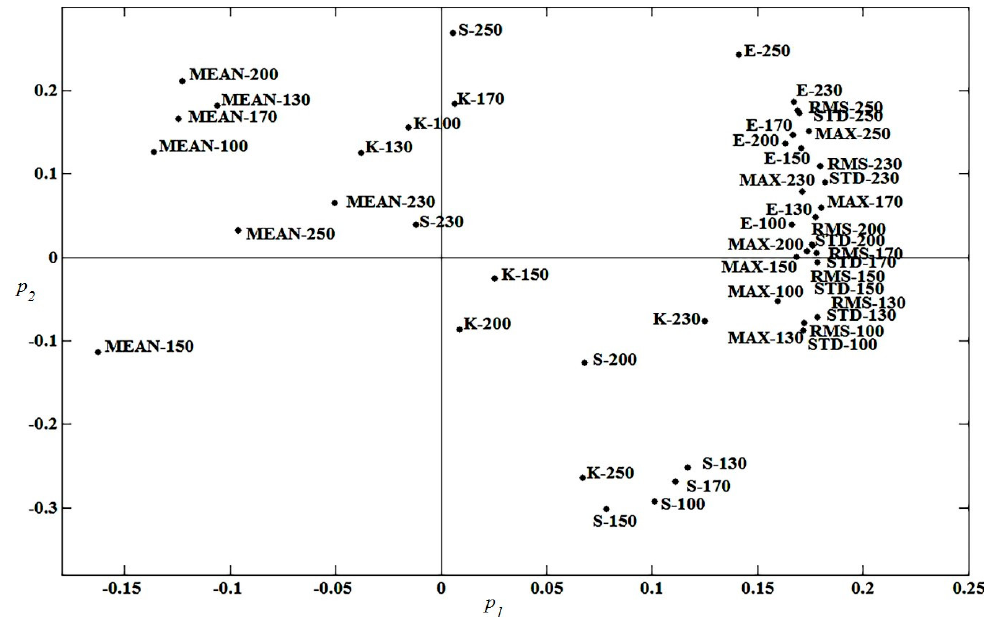
Figure 9. The p 1 – p 2 loading plot of the PCA model built on AU signal attenuation features. MAX: maximum, STD: standard deviation, E: energy, RMS: root mean square, S: skewness, K: kurtosis. Numbers next to the feature names indicate the excitation frequency (kHz).